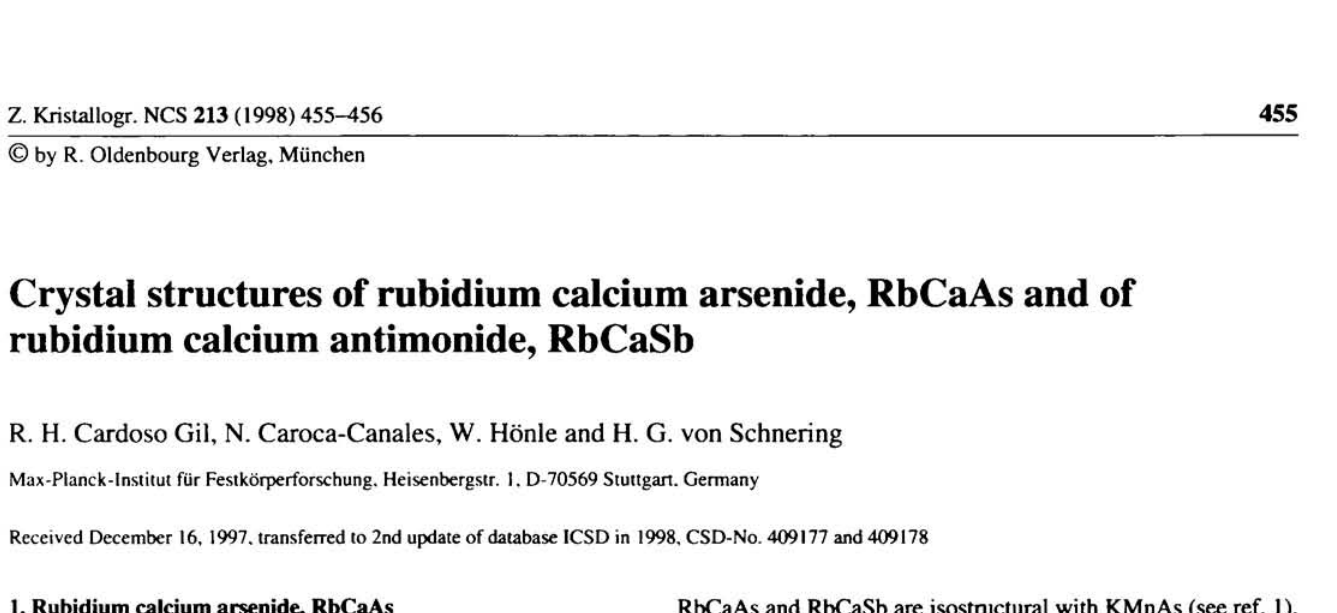
Table 1. Parameters used for the X-ray data collection Crystal: